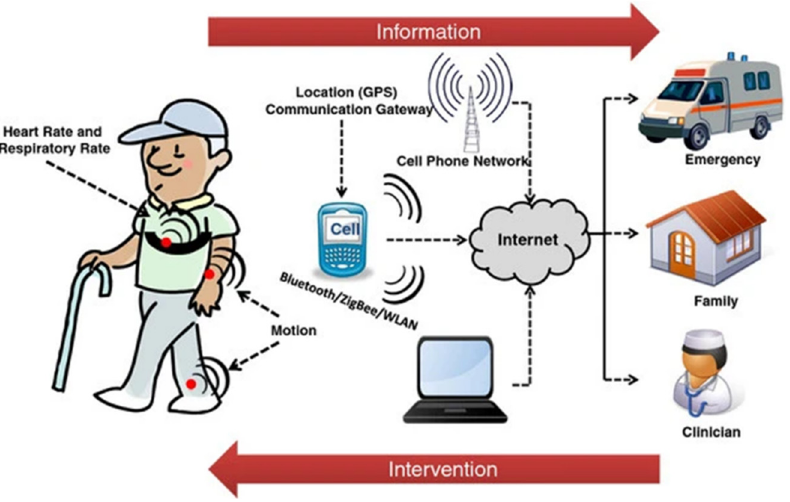
Figure 8. Illustration of a remote health monitoring system based on wearable sensors. Health- related information is gathered via body-worn wireless sensors and transmitted to the caregiver via an information gateway such as a mobile phone. Caregivers can use this information to implement interventions as needed. Figure reproduced from [96] under the terms and conditions of a Creative Commons CC-BY license agreement.